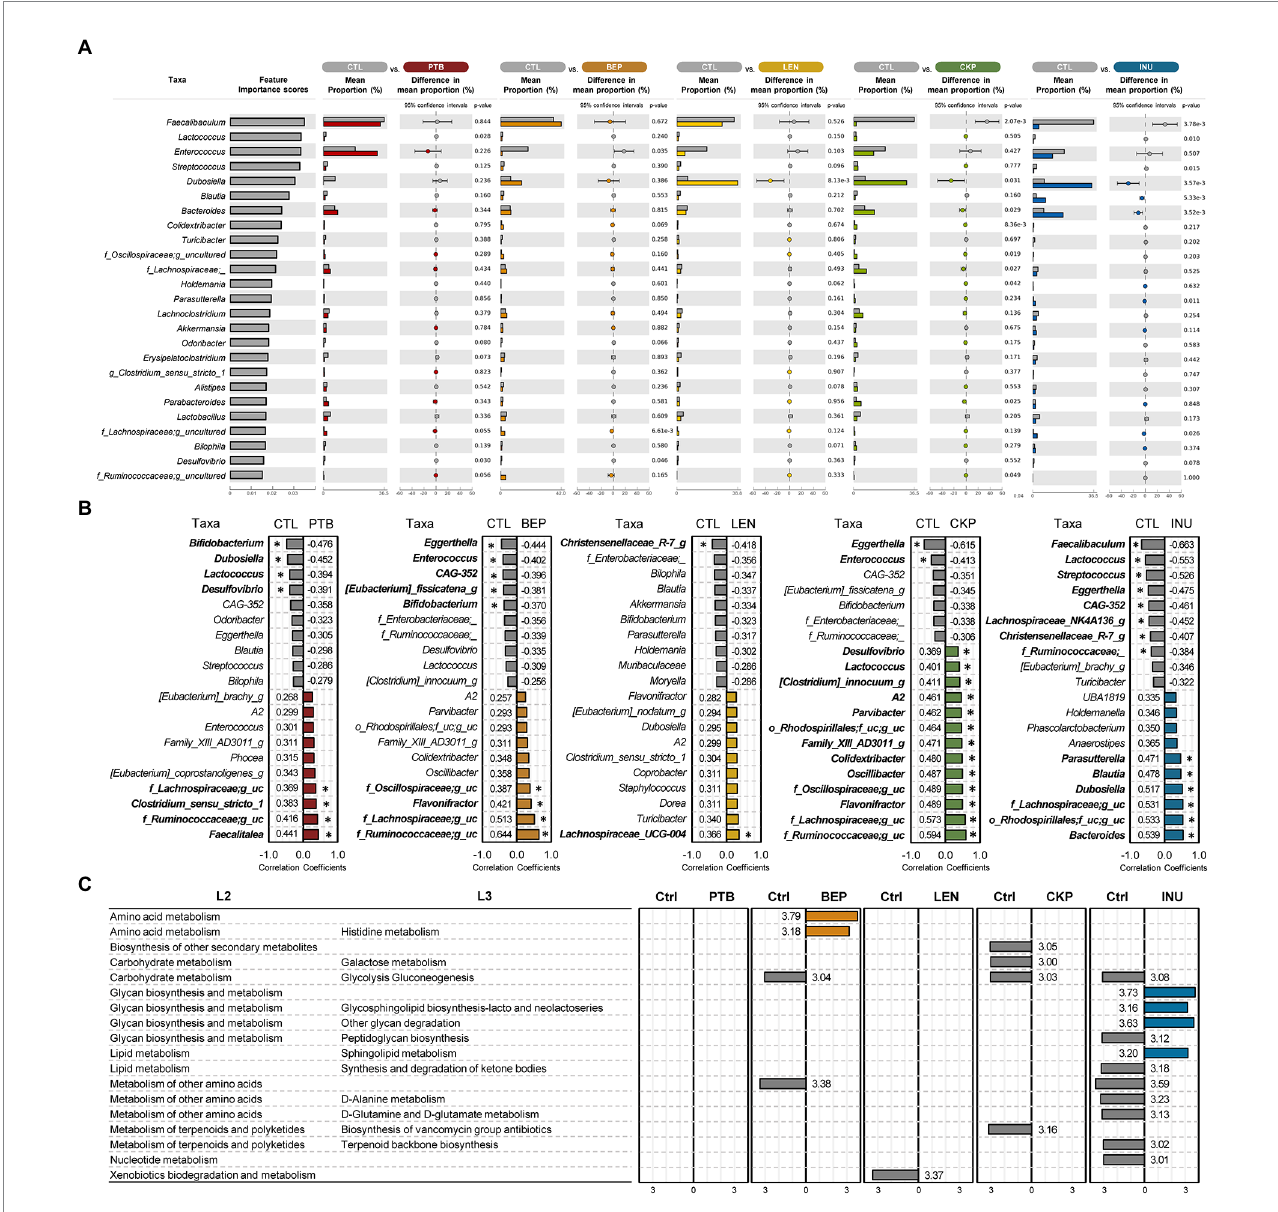
FIGURE 4 Comparison of predictive microbial genera, functional profiles and correlation analysis between resistant starches and control groups. (A) The top 25 most strongly predictive genera ordered by relative importance score used to assess the contribution to classifier accuracy, and extended error bar plots with corrected value of p (Welch’s two-sided t -test) for each taxon. (B) Correlation analysis for top 20 genera. (C) Differences in predictive KEGG functional capabilities using the LEfSe (LDA > 3.0) analysis. PTB, Pinto beans; BEP, black-eyed peas; LEN, Lentils; CKP, chickpeas; INU, inulin; CTL, control high-fat diet group. * p <